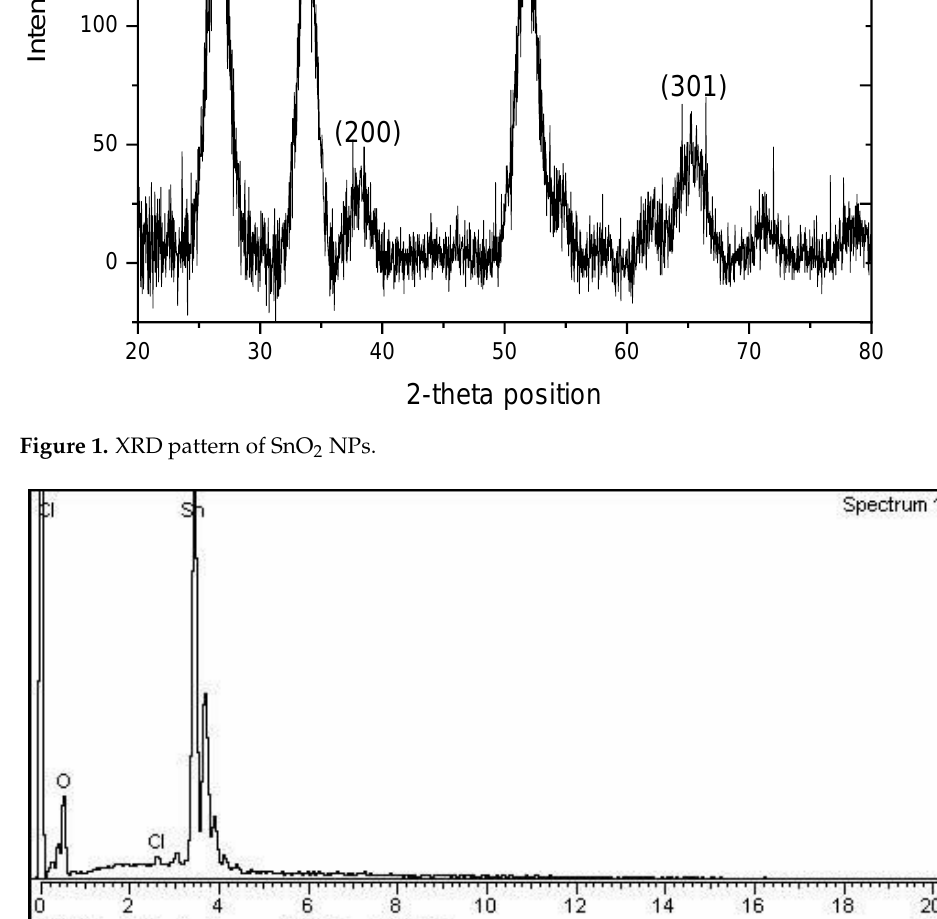
Figure 1. XRD pattern of SnO 2 NPs.